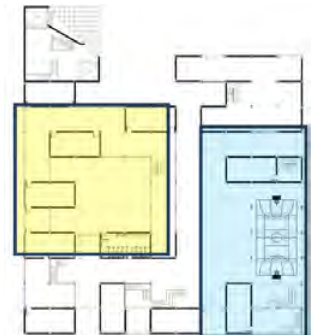
Figure 9. Showing gender separation zones (“Ahmed Shemisah’s” Project)